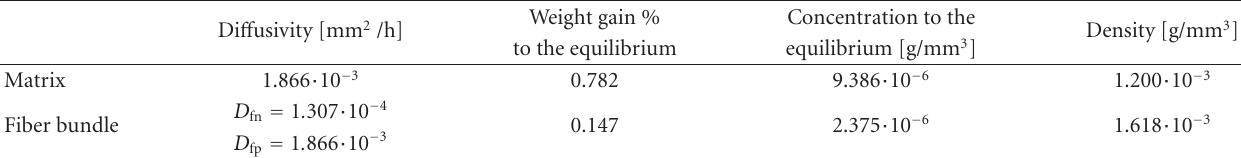
Table 2: Material properties associated with the di ff usion process for carbon-braided RUC.